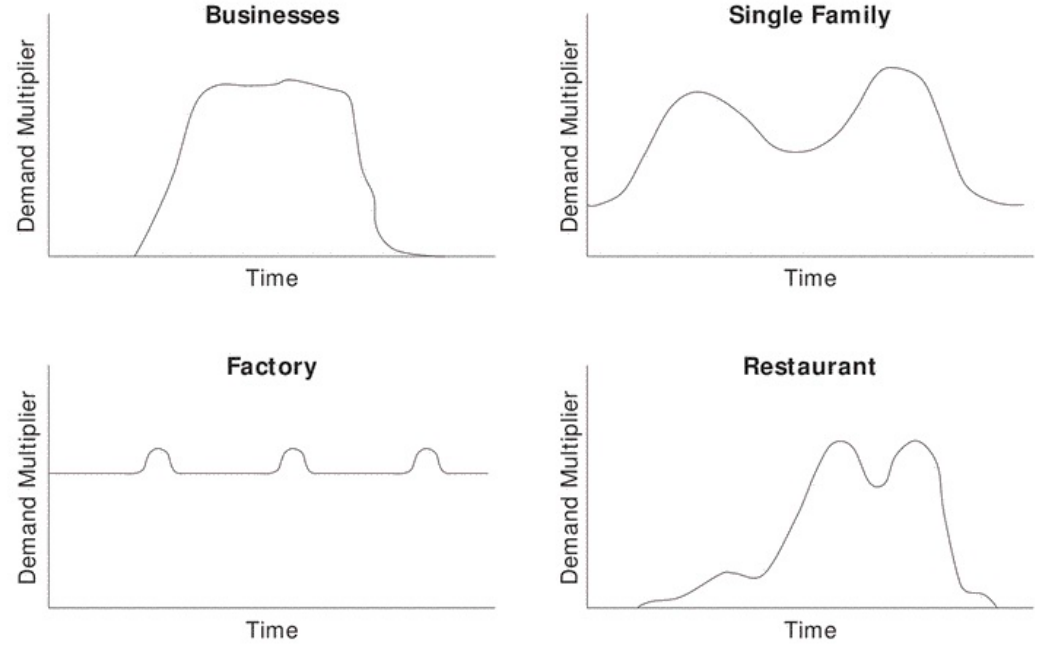
Figure 1. Water consumption patterns for different type of areas